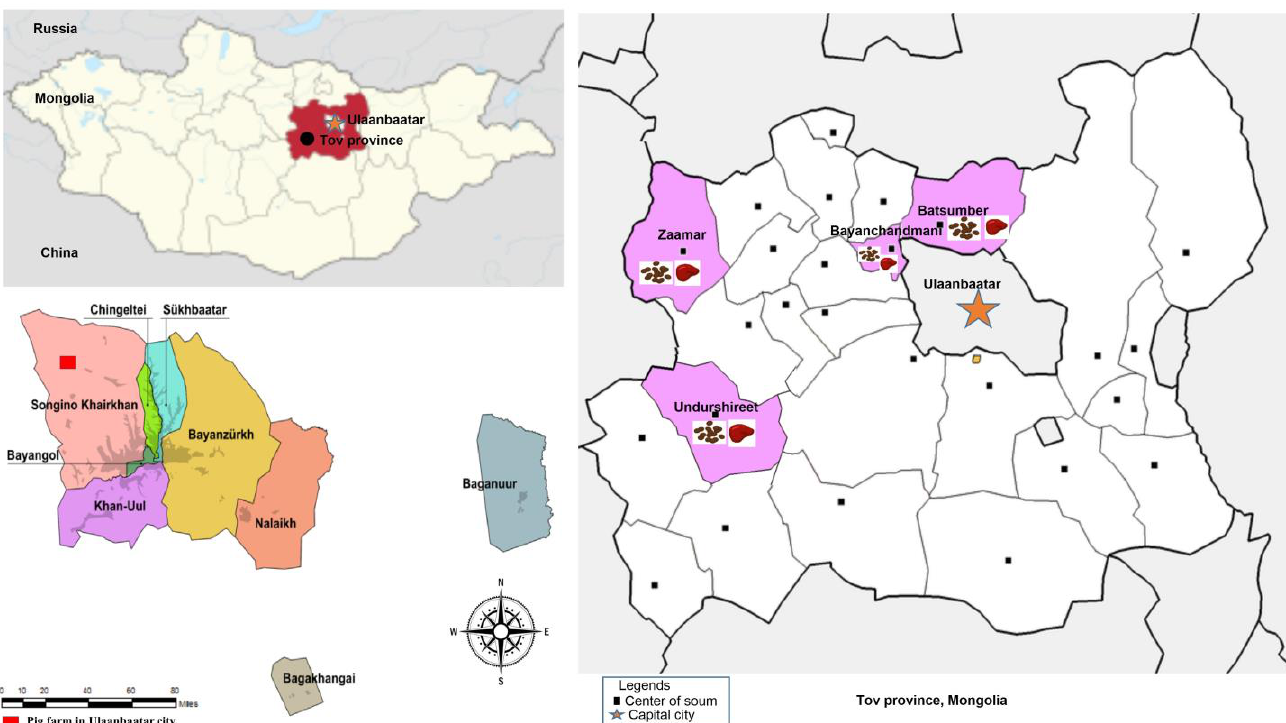
Figure 1. Sampling locations in Mongolia. The upper left figure shows the whole Mongolian territory with two neighboring countries and the locations of Töv Province and the capital city, Ulaanbaatar. The lower left figure shows the whole territory of Ulaanbaatar city and the location of the pig farm in Songino Khairkhan district in the red rectangle. The figure on the right shows the whole territory of Töv Province and the locations of four soums are shown in pink (Zaamar, Undurshireet, Bayanchandmani, and Batsumber soums) where we collected the feces and liver samples of the sheep. In addition, the figure shows that the Bayanchandmani and Batsumber soums are near to the pig farm located in Songino Khairkhan district. Emeelt — the main slaughterhouse in Mongolia — is also in Songino Khairkhan district. The red rectangles show the areas where the pig feces samples were collected.